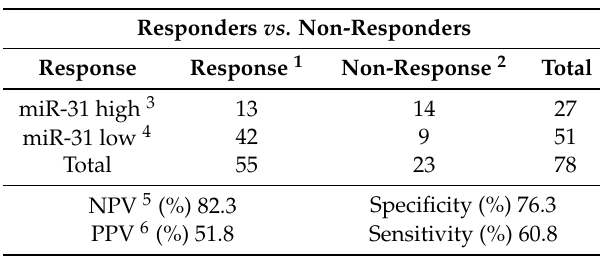
Table 2. MiR-31 predicts pathological response to neoadjuvant CRT.